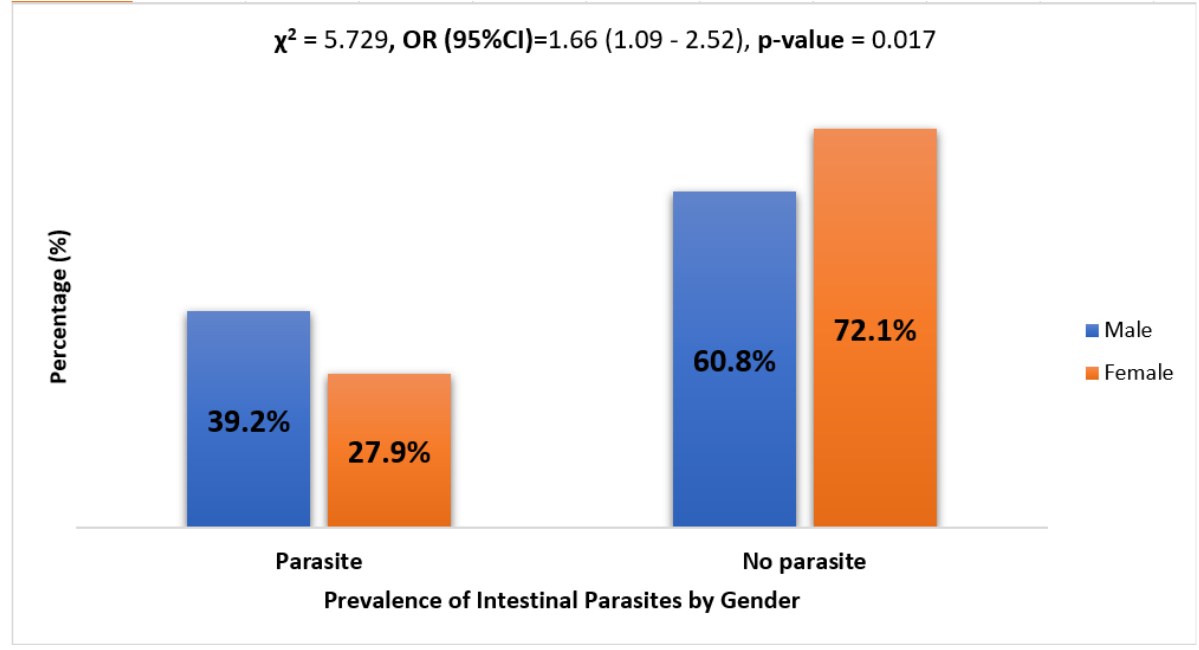
Figure 2. Prevalence of intestinal parasites by gender. Logistic regression analysis results show that males were 1.66 times more likely to have parasites as compared to their female counterparts (OR = 1.66, CI = (1.09 – 2.52), and p -value = 0.017).